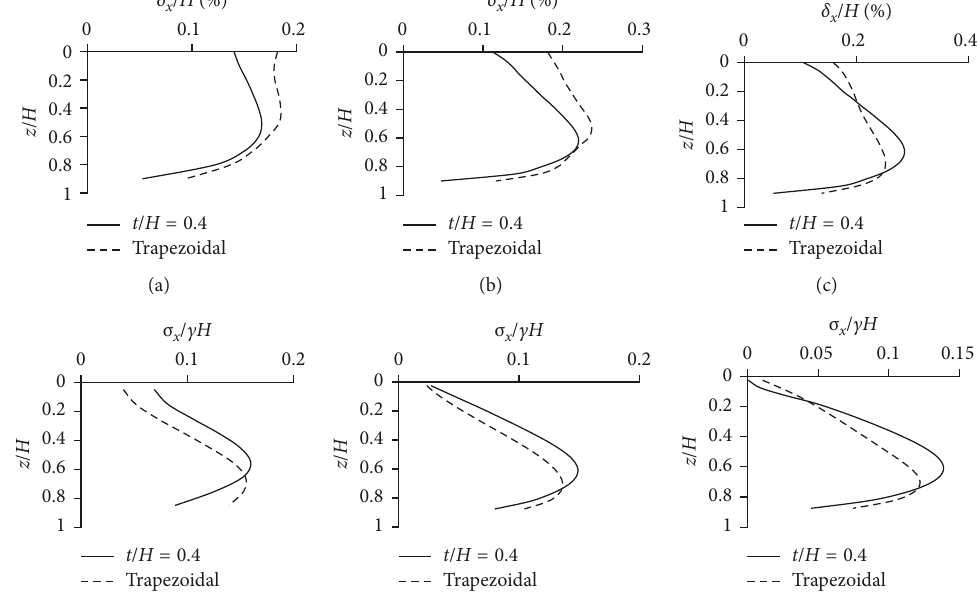
3m. (b) H 6m. (c) H 9 m. (d) H 3m. (cid:31) (cid:31) (cid:31) (cid:31)